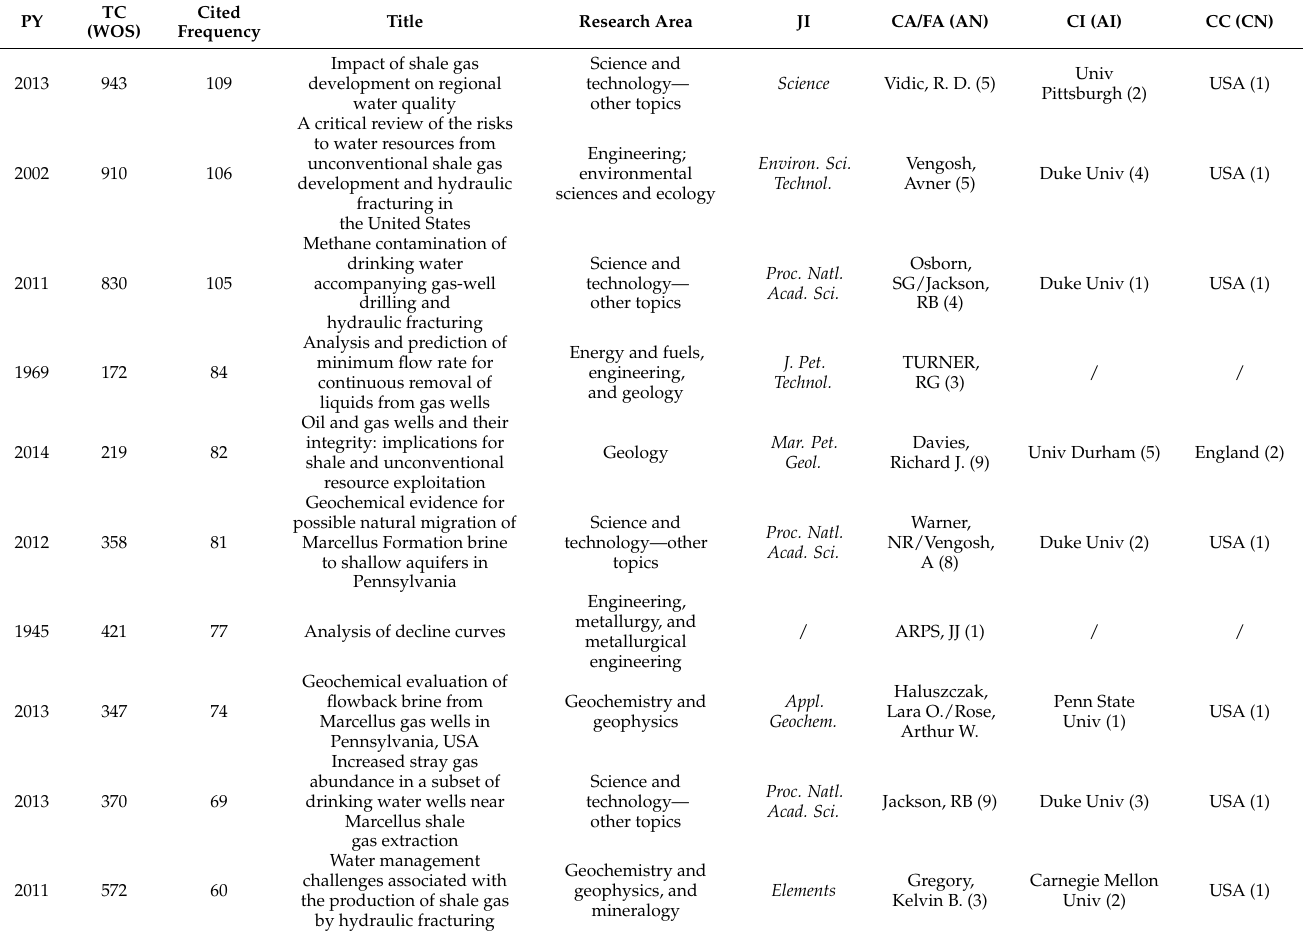
Table 2. Most influenced papers extracted from the literature co-citation